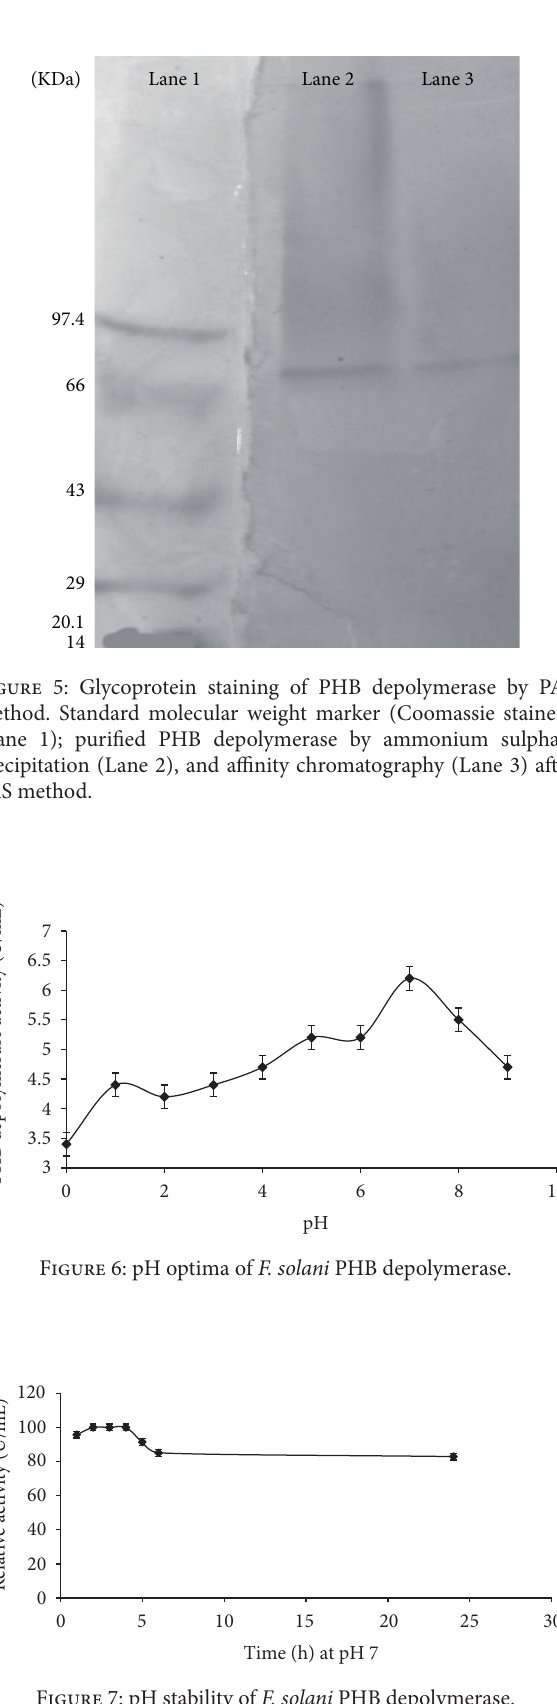
F 7: pH stability of F. solani PHB depolymerase.